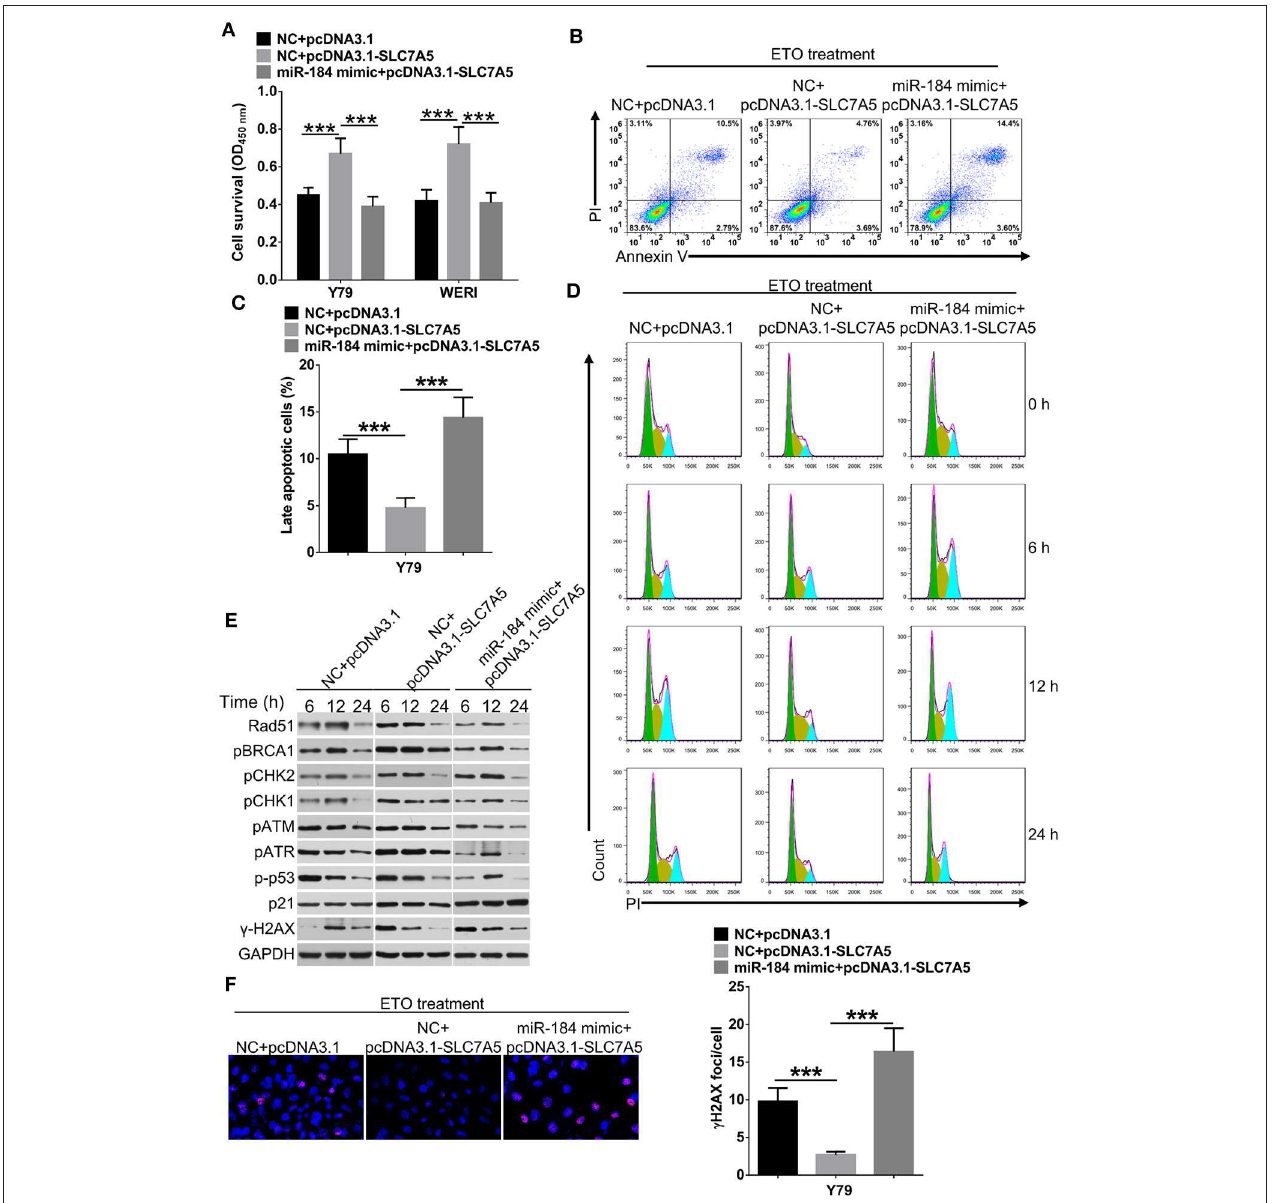
FIGURE 6 | miR-184 enhances apoptosis and G2/M phase arrest of retinoblastoma (RB) cells in response to etoposide (ETO) treatment via inhibiting SLC7A5. (A) Y79 cells transfected with miR-184 mimic alone or together with SLC7A5 expression vector (pcDNA3.1-SLC7A5) were treated with ETO (0.25 µ M) for 48h. Cell survival was detected by MTT assay. (B) Y79 cells transfected with miR-184 mimic alone or together with SLC7A5 expression vector (pcDNA3.1-SLC7A5) were treated with ETO (0.25 µ M) for 48h. Cellular apoptosis was detected by flow cytometry. (C) Statistical analysis of the Annexin V + PI + -positive cell ratio in Y79 cells. (D) Forty-eight hours after transfection with miR-184 mimic alone or together with SLC7A5 expression vector (pcDNA3.1-SLC7A5), Y79 cells were treated with ETO (0.25 µ M), and cell cycle distribution was detected by flow cytometry at each time point. (E) Forty-eight hours after transfection with miR-184 mimic alone or together with SLC7A5 expression vector (pcDNA3.1-SLC7A5), Y79 cells were treated with ETO (0.25 µ M), and expressions of DNA damage sensor proteins in the ATM/ATR pathways were detected by Western blot at each time point. (F) Forty-eight hours after transfection with miR-184 mimic alone or together with SLC7A5 expression vector (pcDNA3.1-SLC7A5), Y79 cells were treated with ETO (0.25 µ M) for 24h, and γ H2AX foci were detected by immunofluorescence. Statistical analysis of γ H2AX foci in Y79 cells, which were counted in at least 100 randomly selected cells per sample. Data were presented as mean ± SD of three independent experiments. *** P < 0.0001 vs. negative control